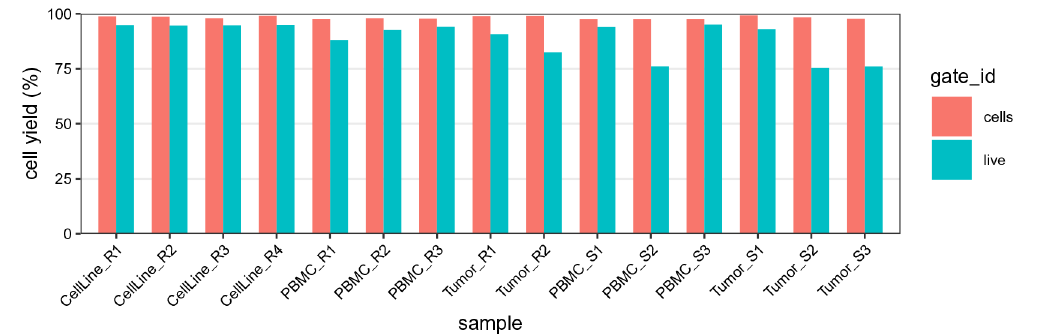
Figure 12. Barplot of cell and live gating yields. For each barcode ID (x-axis), frequencies are relative to the total number of cells in the population before gating; bars are colored by gate ID.